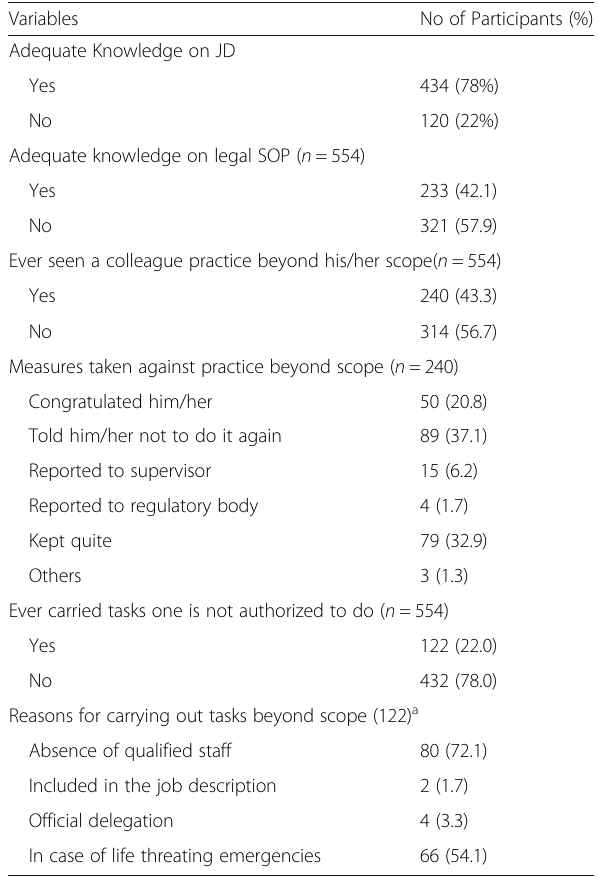
Table 3 Experiences regarding Scope of Practice, exploring health workforce regulation practices and gaps, Ethiopia,